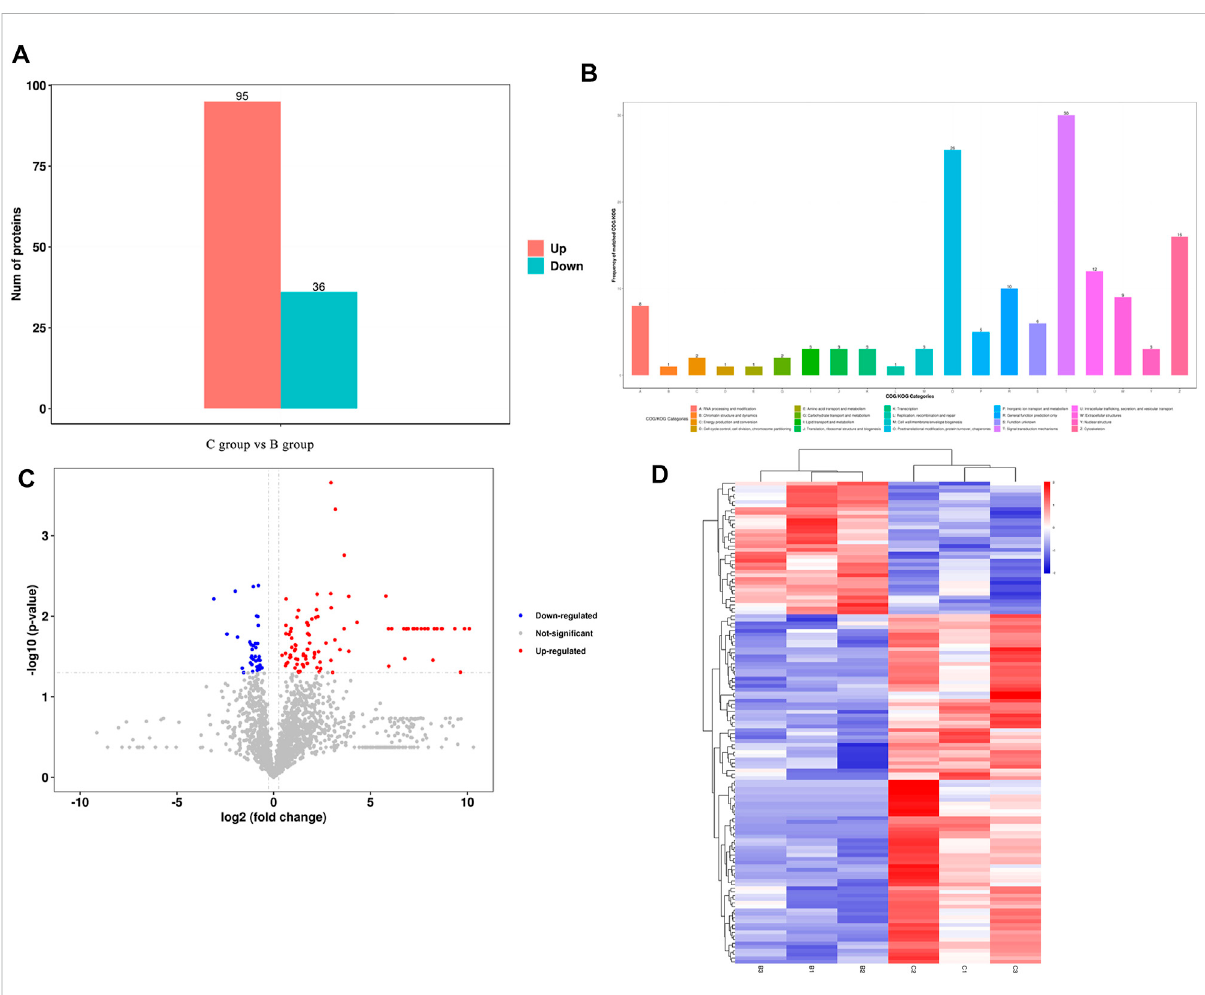
FIGURE 8 (A) Differentiallyexpressedproteinsbetweengroup (C,B) ; (B) Numberofproteinscorrespondingtothe fi rst20itemsofCOG/KOGanalysCOG/ KOG; (C) Volcano diagram of the DEPs between group (C,B) ; (D) Clustering heat map of DEPs between group (C,B) .